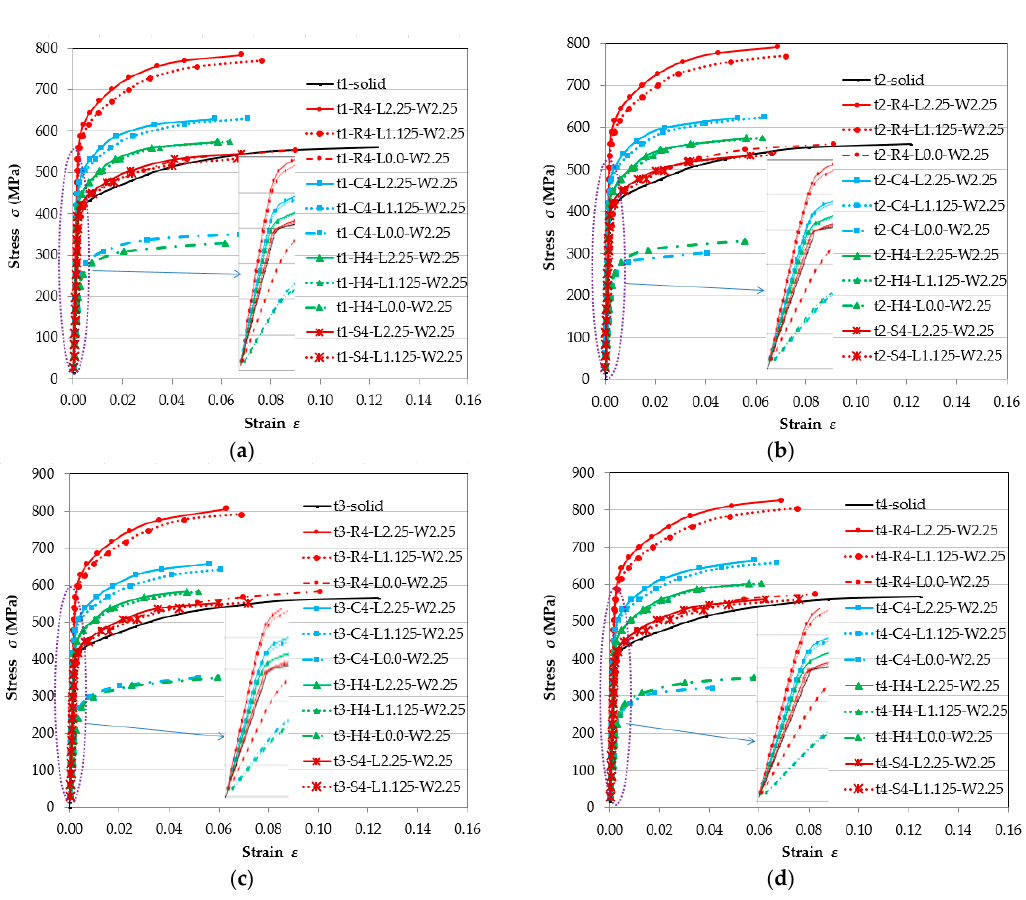
Figure 7. Stress-strain engineering relationships obtained from FE simulation for perforated steel sheets. ( a ) Steel sheets thickness = 1 mm; ( b ) Steel sheets thickness = 2 mm; ( c ) Steel sheets thickness = 3 mm; ( d ) Steel sheets thickness = 4 mm.